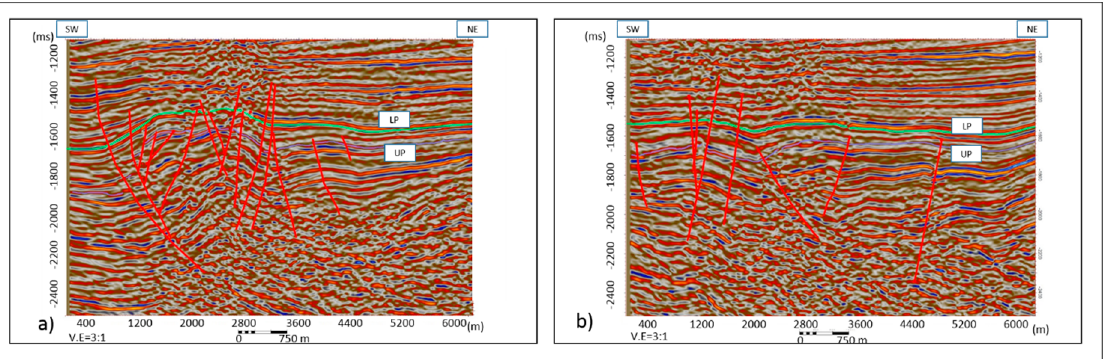
Figure 5. Seismic section of the mapped horizons ( a ) “UP” (Upper Pannonian) reservoir and ( b ) “LP” (Lower Pontian) reservoir.